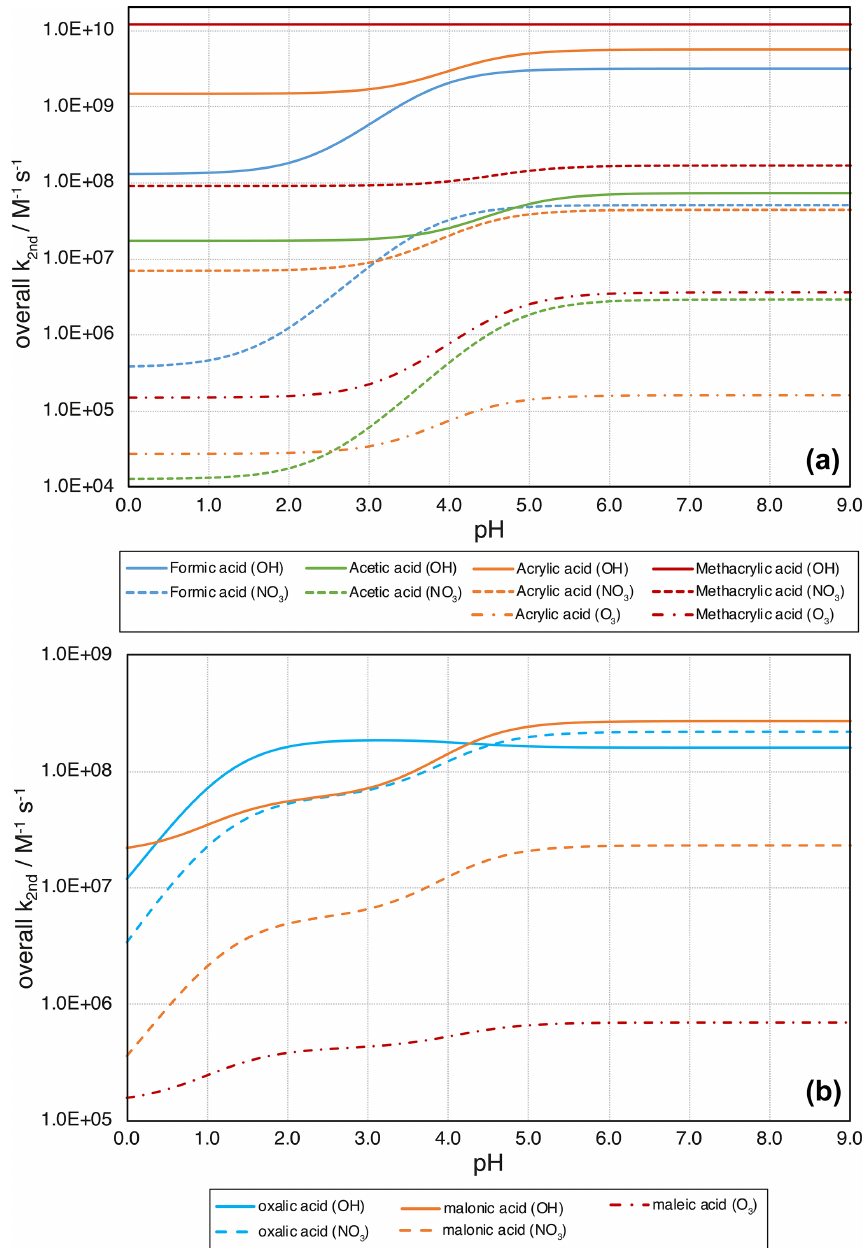
Figure 18. Overall condensed-phase second-order rate constant k 2nd as a function of pH of selected mono- (a) and dicarboxylic (b) acids for different radical (OH / NO 3 ) and non-radical (O 3 )